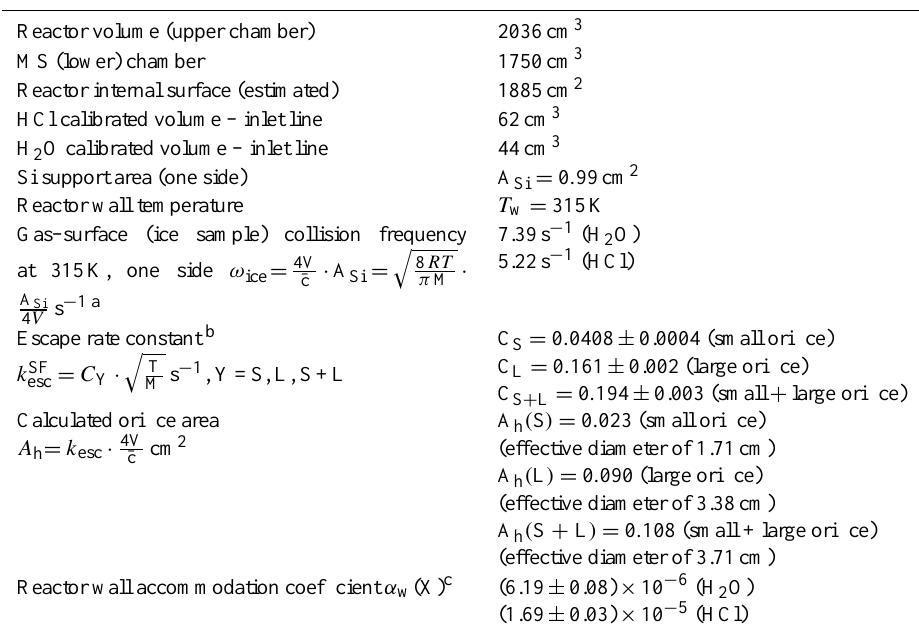
Table 1. Characteristic parameters of the used stirred flow reactor